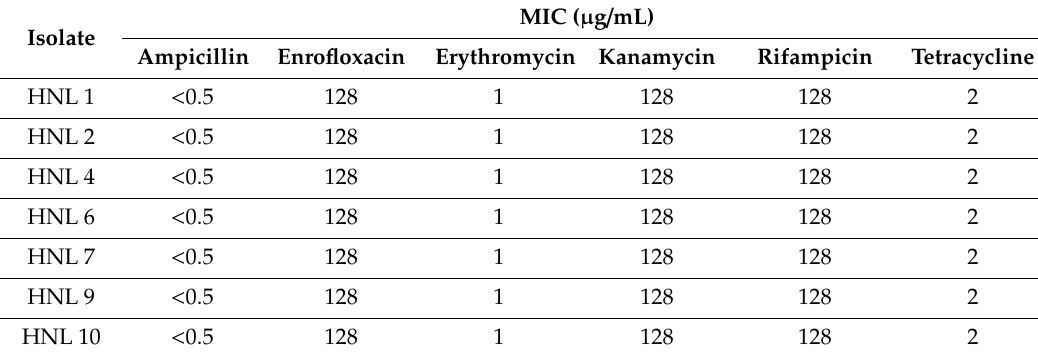
Table 2. The minimum inhibitory concentration of six antimicrobial agents to T. phagedenis isolates. MIC ( µ g / mL) Isolate Ampicillin Enrofloxacin Erythromycin Kanamycin Rifampicin Tetracycline HNL 1 < 0.5 128 1 128 128 2 HNL 2 < 0.5 128 1 128 128 HNL 4 < 0.5 128 HNL 6 < 0.5 128 128 HNL 7 < 0.5 128 128 HNL 9 < 0.5 128 128 HNL 10 <